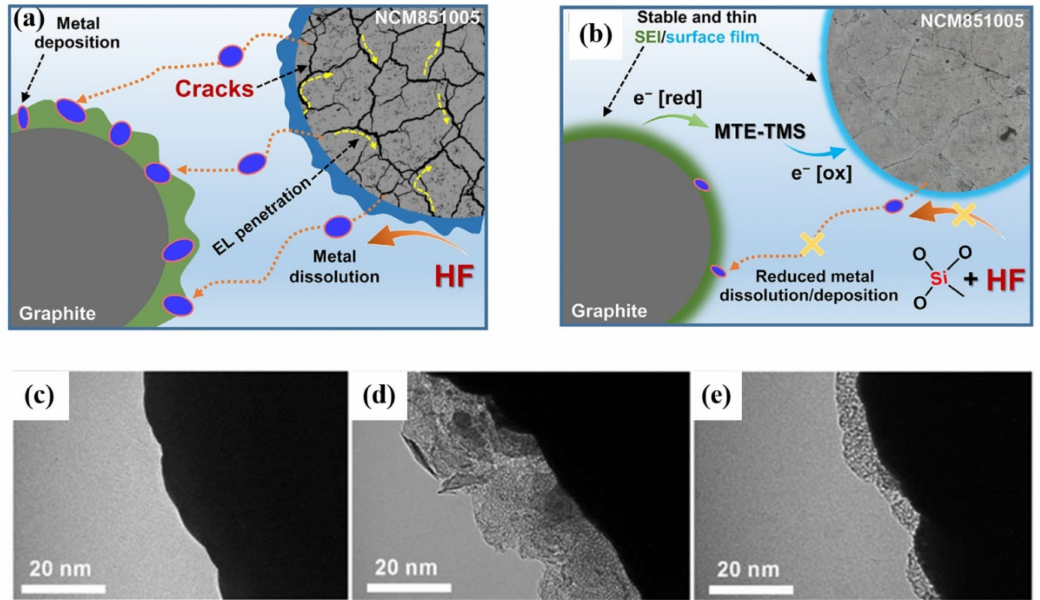
Figure 11. Schematic diagram for interfacial phenomena occurring in the graphite (cid:107) NCM851005 full-cells, cycled between 3.0 and 4.25 V in the standard electrolyte ( a ) without and ( b ) with MTE-TMS additive. Reproduced with permission from ref. [123]. Copyright 2020 Elsevier. Corresponding TEM images ( c ) Pristine NCM851005 cathode and cathodes cycled ( d ) without and ( e ) with AEDB additive, taken from graphite (cid:107) NCM851005 full-cells after 100 cycles. Reproduced with permission from ref. [11]. Copyright 2021 John Wiley and